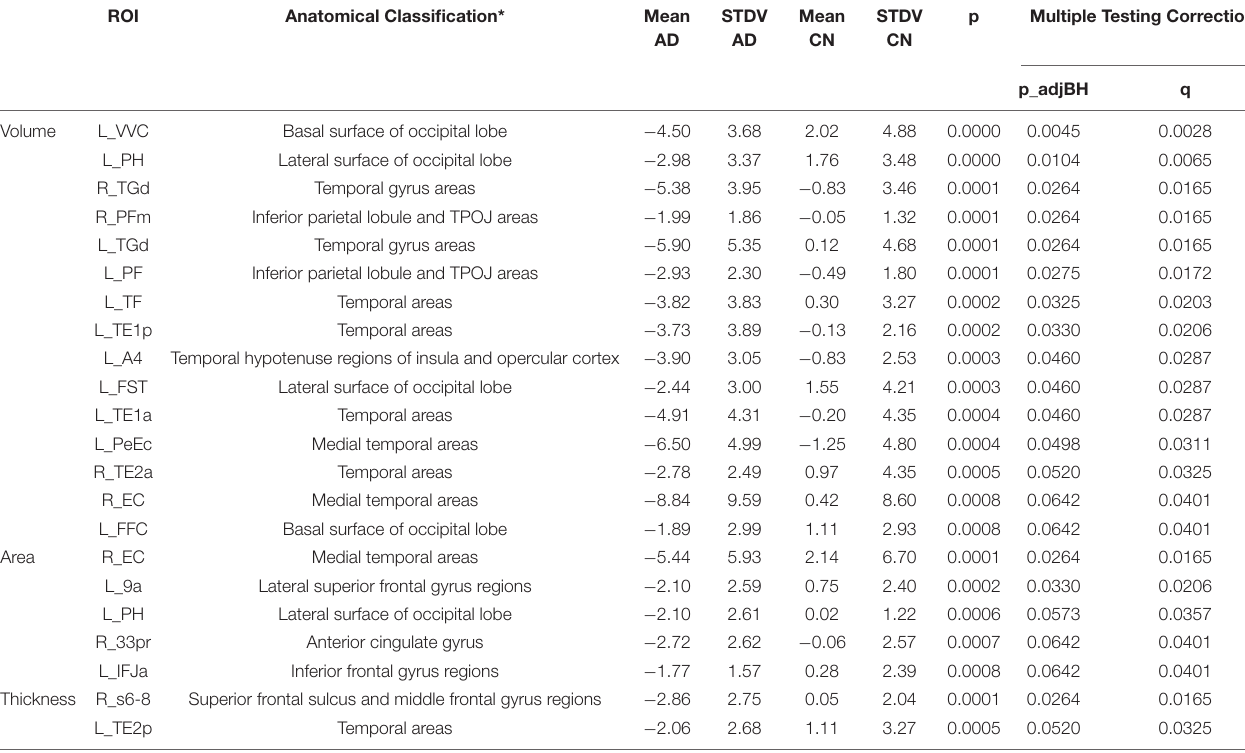
TABLE 3 | Significant results from SBM after multiple testing